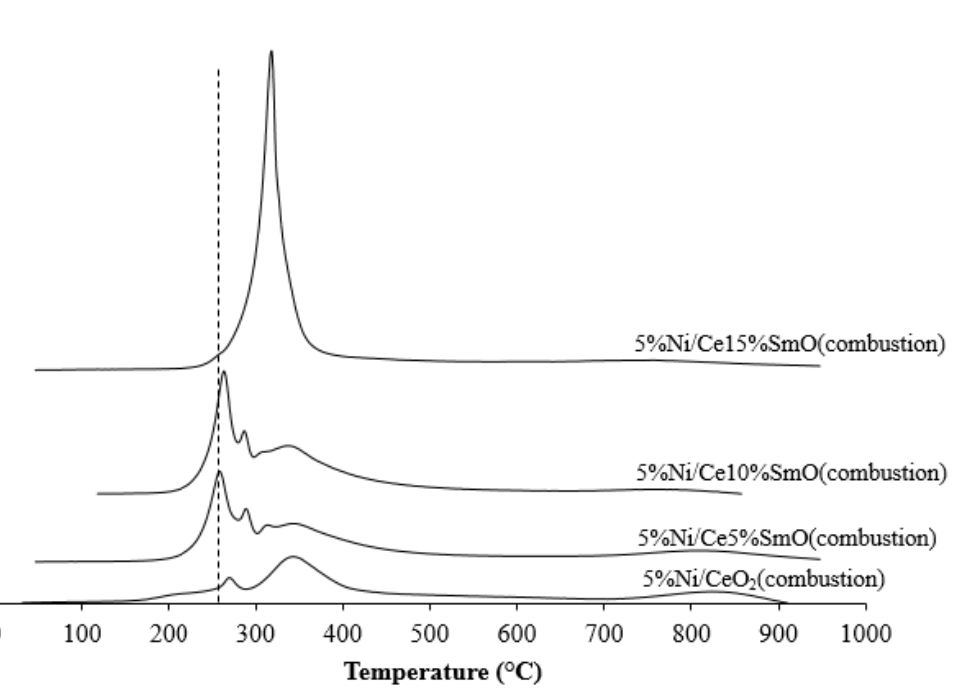
Figure 3. H 2 -TPR profiles of supported Ni catalysts prepared by different methods.